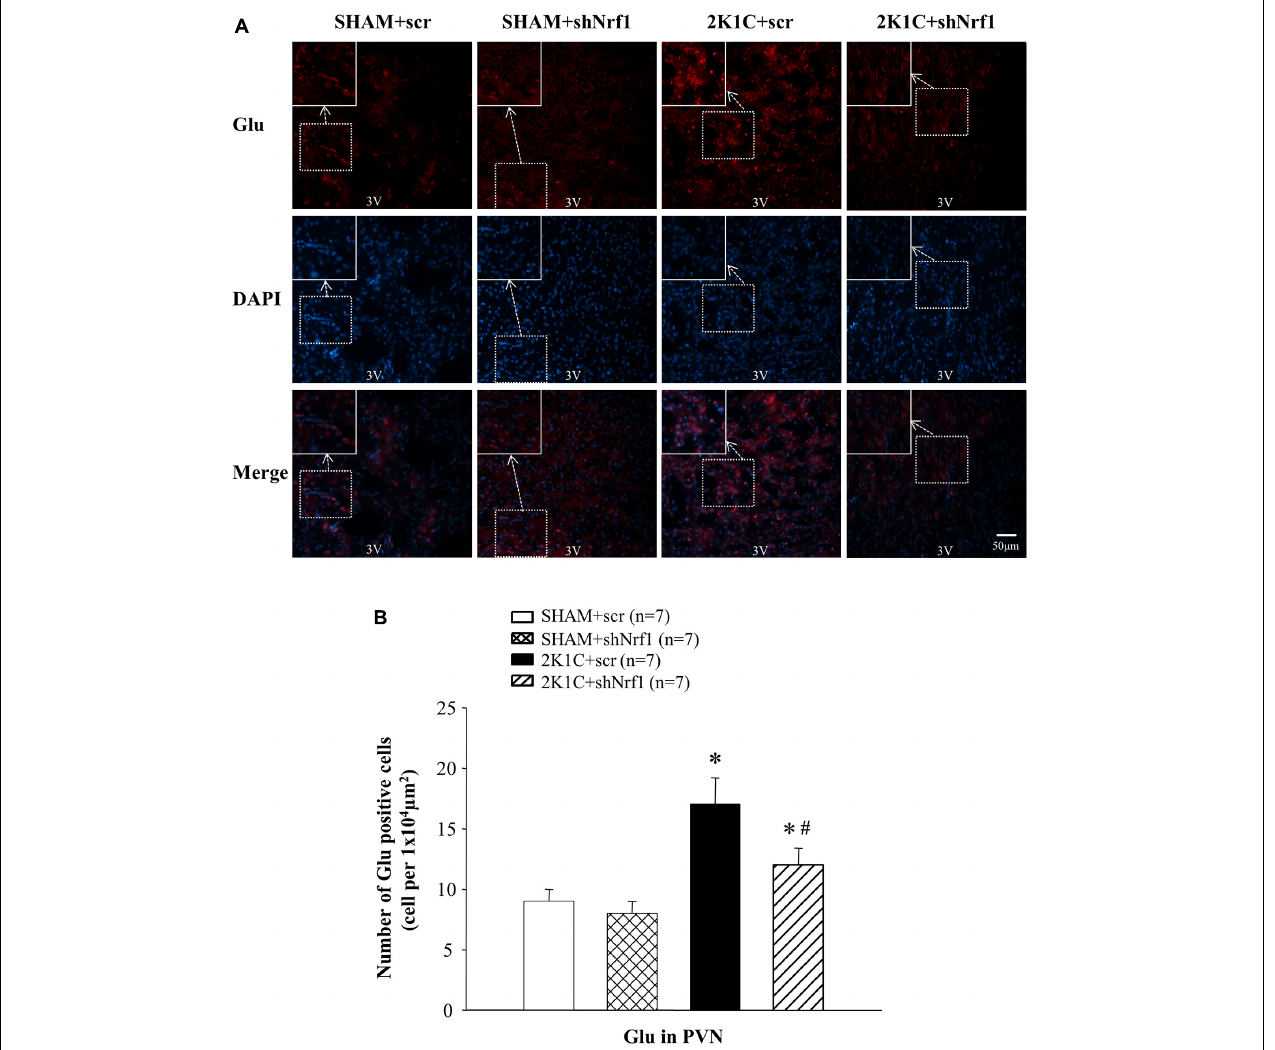
FIGURE 6 | Effects of knocking down of Nrf1 on Glu in PVN of hypertensive rats. (A) Immunofluorescence for the expression of Glu in PVN in different groups. (B) Changes of the number of Glu positive cells in PVN. ∗ P < 0.05 vs. control animals (SHAM + scr or SHAM + shNrf1). # P < 0.05 2K1C + shNrf1 vs. 2K1C +